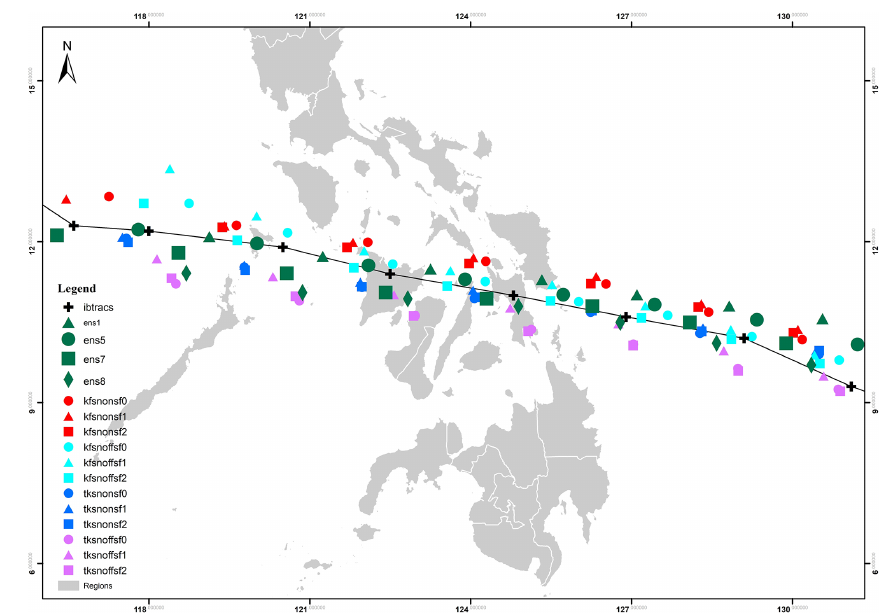
Figure 9. Simulated tracks of the four randomly selected EDA ensemble members (green) compared with IBTrACS and the sensitivity experiments classified according to experiment groups: Kain–Fritsch (KF) convection scheme, Tiedtke (TK) convection scheme, with spectral nudging (snON), without spectral nudging (snOFF), surface flux option 0 (sf0), option 1(sf1), and option 2 (sf2).